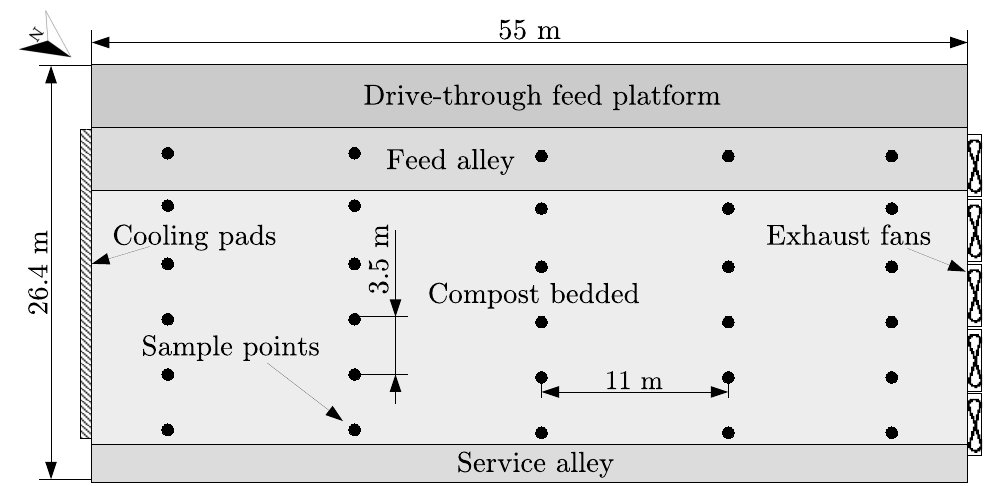
Figure 2. Dimensions and measured points inside the closed compost dairy barn